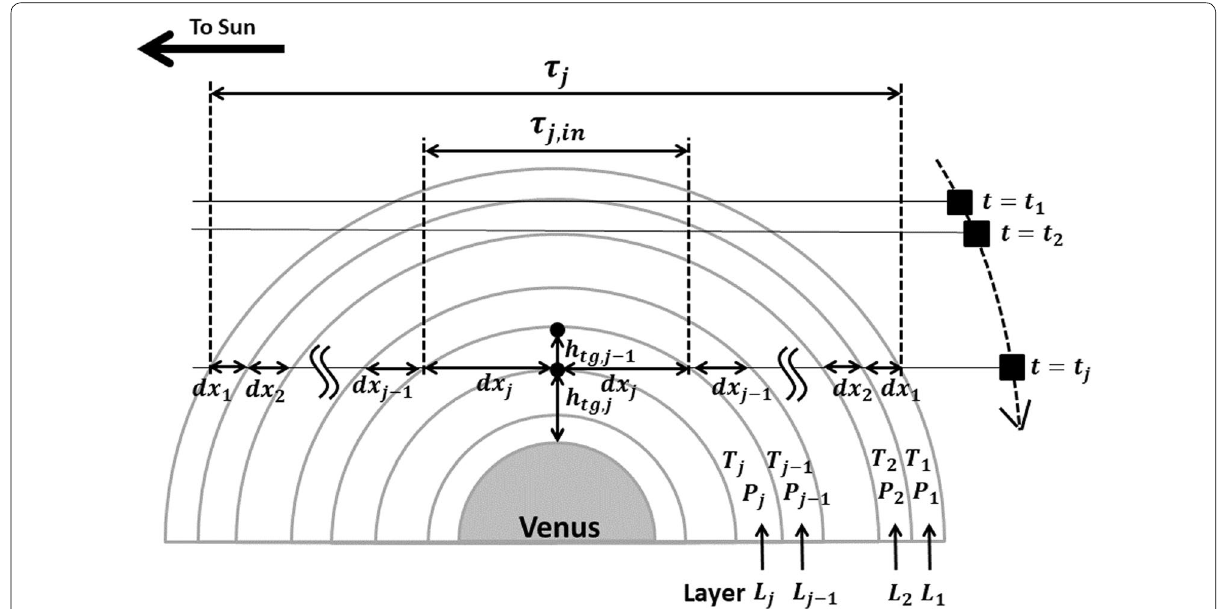
Fig. 1 Geometry of solar occultation measurements and the analysis method in this study (modified from Fig. 4 of Vandaele et al. 2008). In the ingress case depicted here, the instrument is taking a measurement every second. The tangent altitude h tg , j defines the layers in the atmosphere. In each layer L i , the temperature T i and pressure P i are assumed to be constant